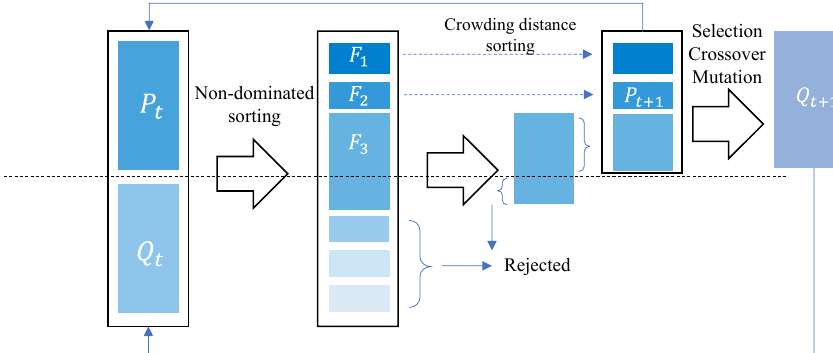
Figure 4. The NSGA-II procedure.